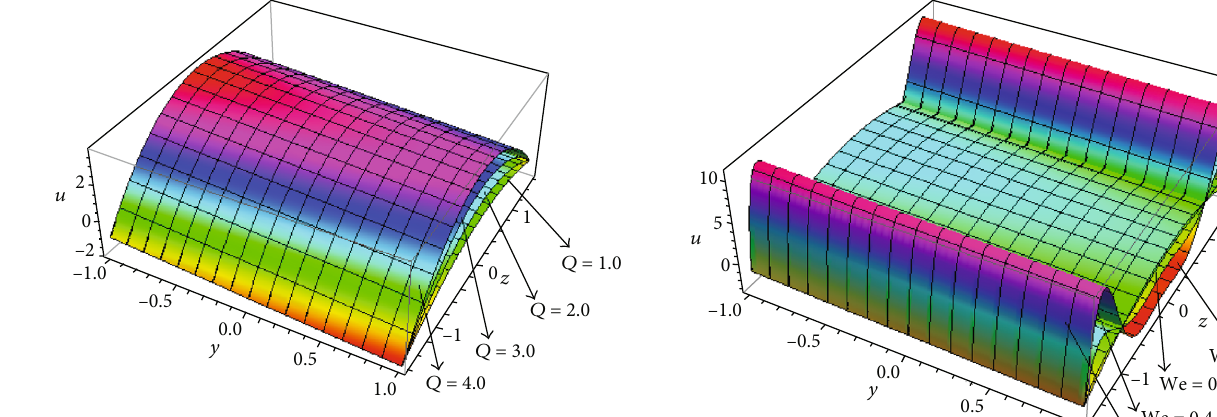
Figure 18: Velocity pro fi le for di ff erent values of Q . The other parameters are φ = 0 : 6 , x = 0 , β = 0 : 5 , We = 0 : 03 , and n = 1 .